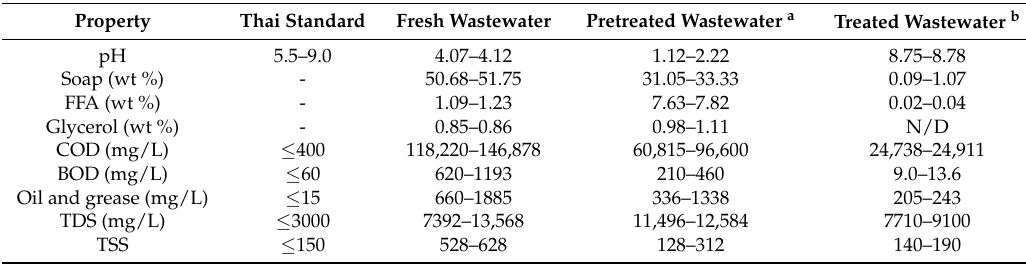
Table 1. Properties of the fresh, acid-pretreated and UV-TiO 2 -treated biodiesel wastewater. COD, chemical oxygen demand; BOD, biological oxygen demand.